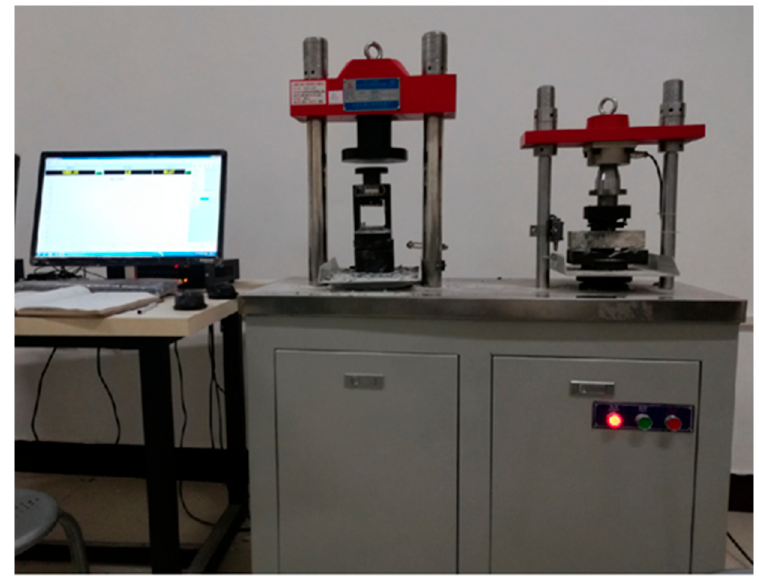
Figure 17. Automatic compressive and flexural testing machine.